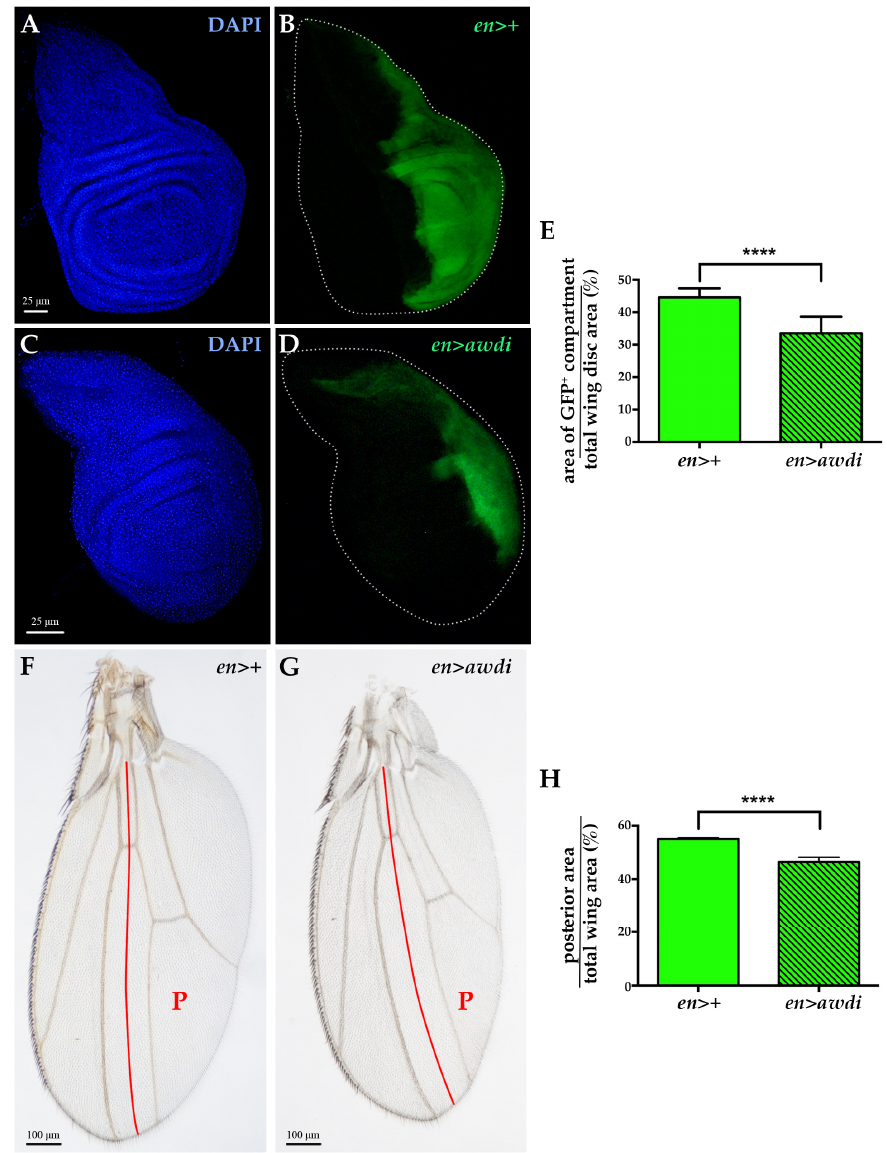
Figure 2. Posterior compartment reduction in en > awdi wing disc and adult wing. ( A – D ) Fluorescence microscopy image of wing discs dissected from en >+ ( A , B ) and en > awdi ( C , D ) larvae. Wing discs are labelled by DAPI ( A , C ) and GFP ( B – D ). Quantification of the average of the posterior area (GFP) / total area ratio in wing discs ( E ). Light micrographs of adult wings dissected from en >+ ( F ) and en > awdi ( G ) males. Quantification of the average of the posterior area (GFP) / total area ratio in adult wings ( H ). The red line marks the boundary between the anterior and posterior (P) compartments. The graphs represent the mean ± SD; **** = p < 0.0001.